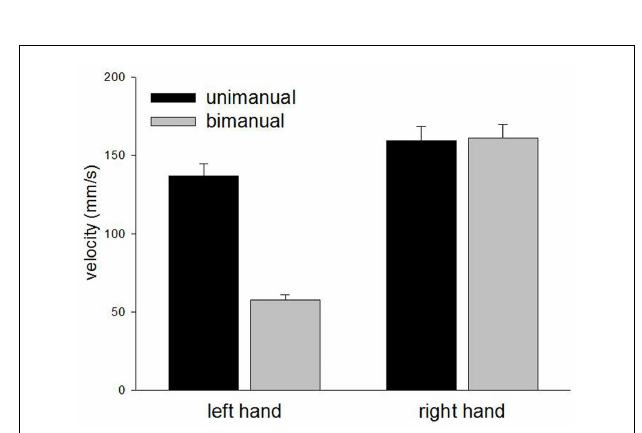
FIGURE 4 | Mean velocity for unimanual and bimanual movements in Experiment 1